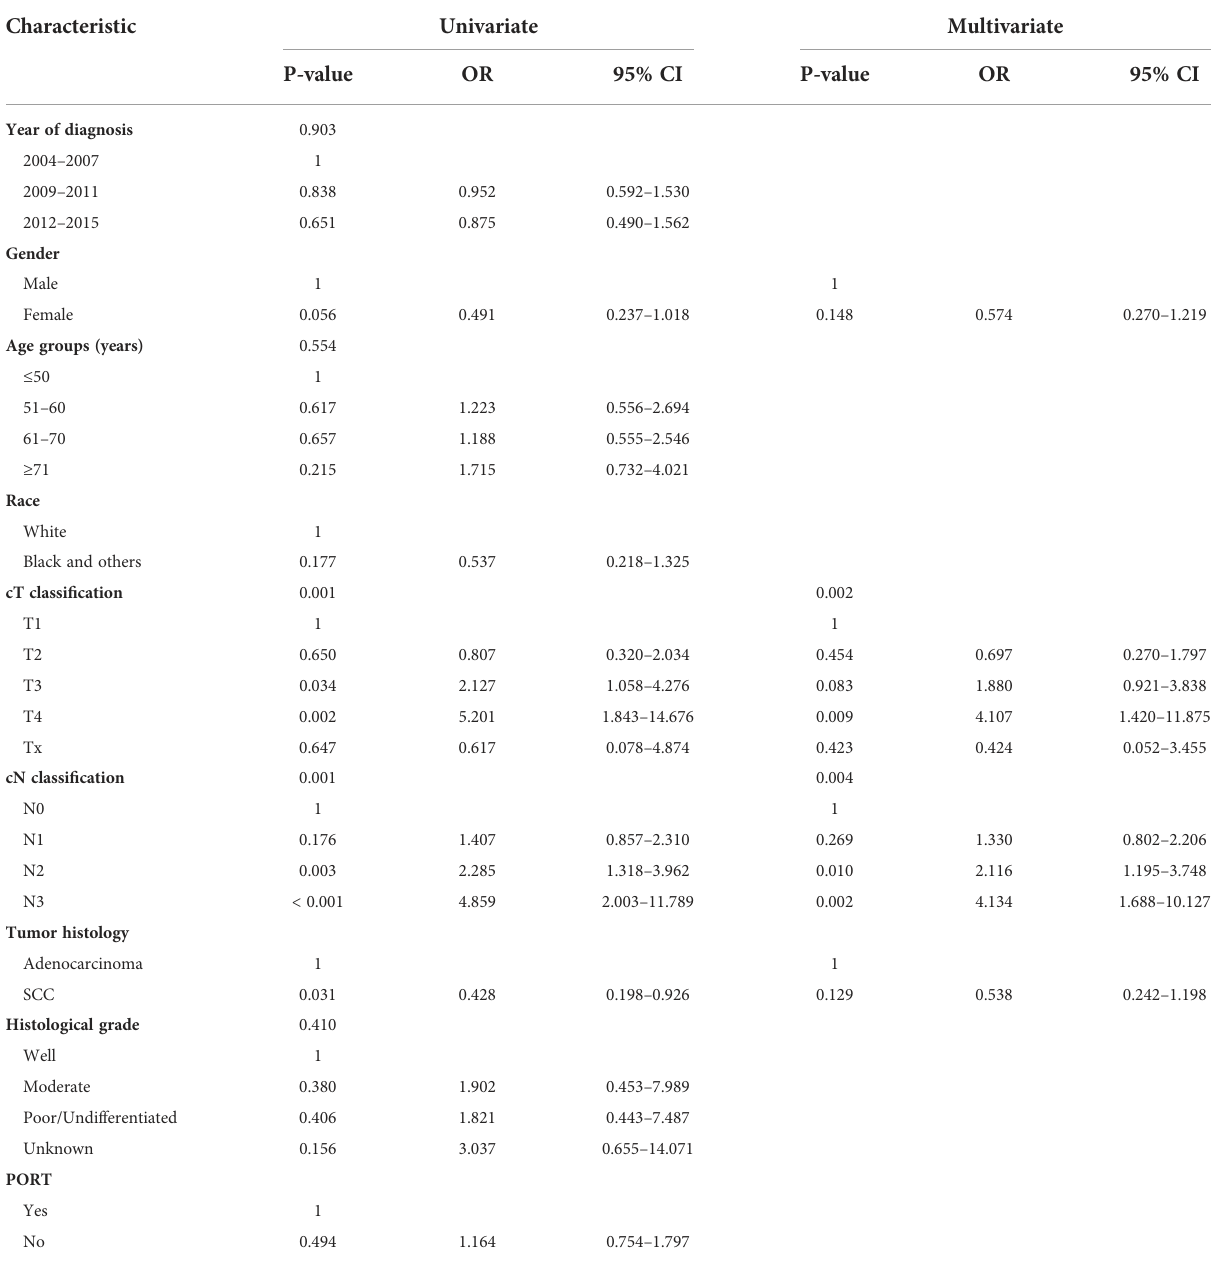
TABLE 3 Univariate and multivariate analysis of CSS for the matched cohort after PSM.